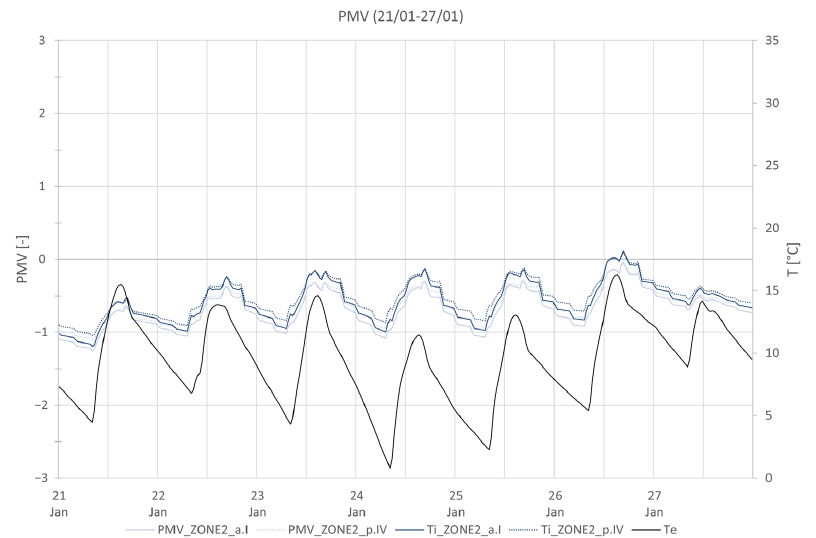
Figure 15. Comparison between PMV in current and low-e configuration during a typical winter week (floor 2).